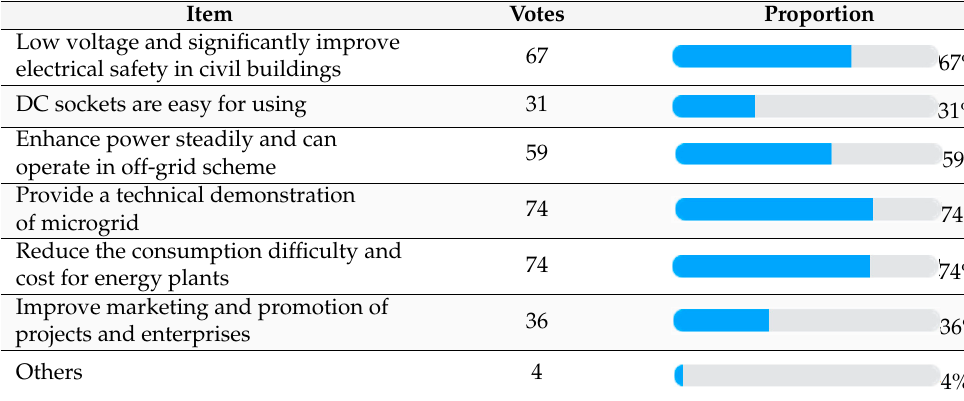
Table 3. Values created by LVDC buildings.